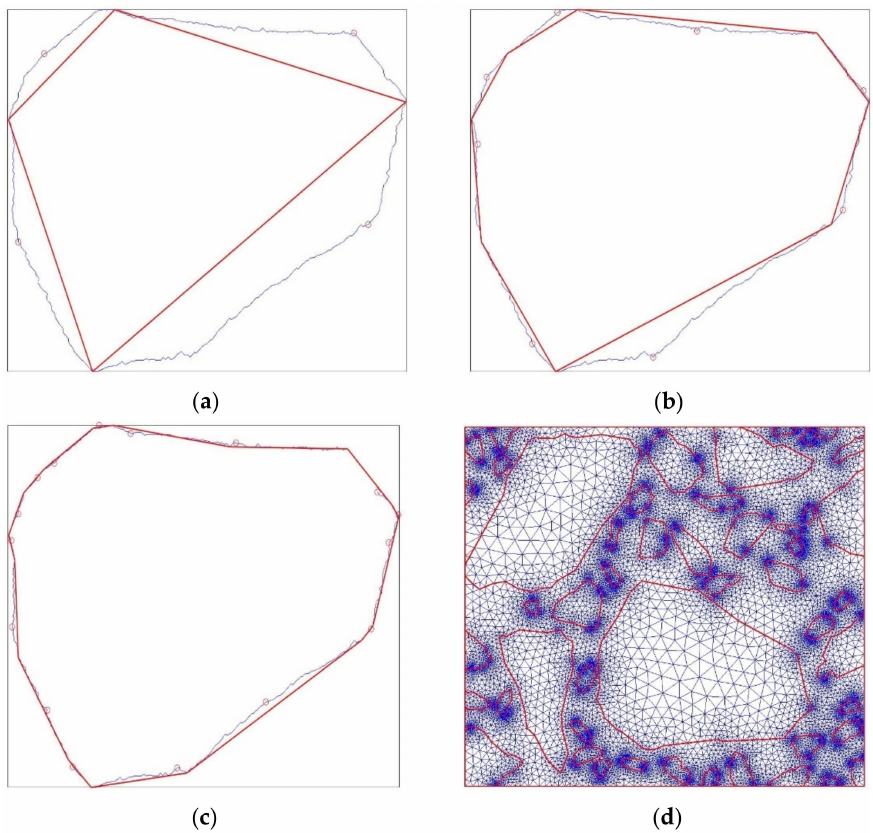
Figure 8. Specification of the outermost boundary pixels and the corresponding initial approximated inclusion geometry ( a ). Results of 2 subsequent iterations of the algorithm ( b – d ) the fine mesh obtained for the last approximated geometry. In ( a , c ), the light blue curve denotes the initial inclusion boundary and the red one shows its approximated counterpart. A single small red circle denotes the pixel from the boundary with the largest distance from the corresponding edge of the approximated geometry. In the next iteration, this point becomes a new